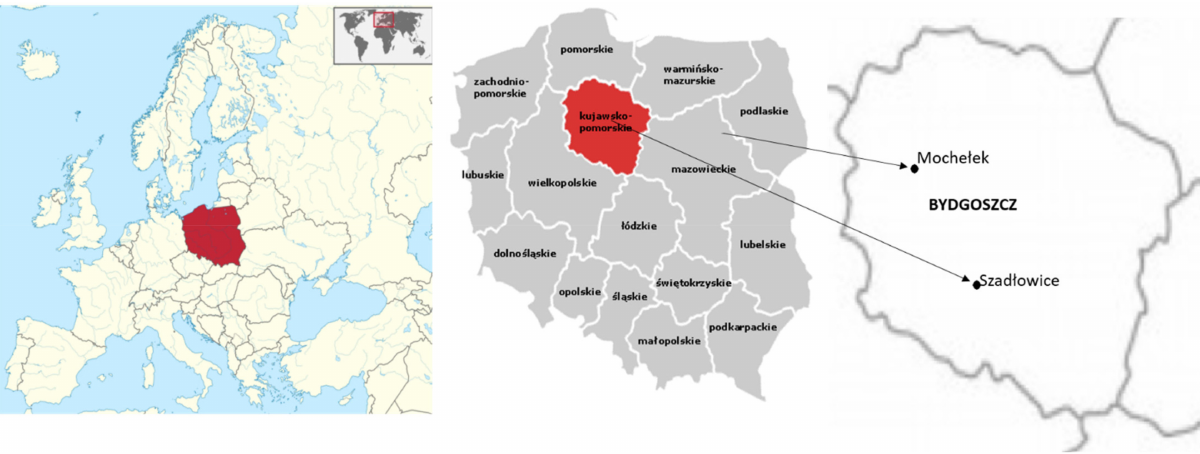
Figure 1. Site of field experiments in the Kuyavian-Pomeranian voivodeship, Poland